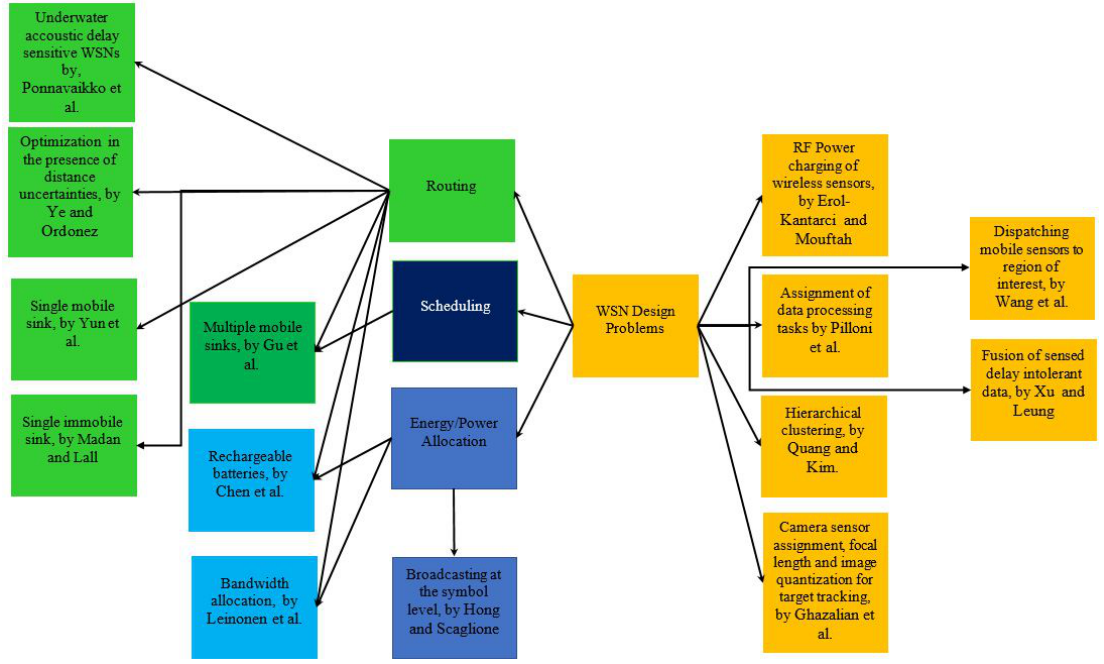
Figure 1. Taxonomy of the wireless sensor network (WSN) design problems considered in this